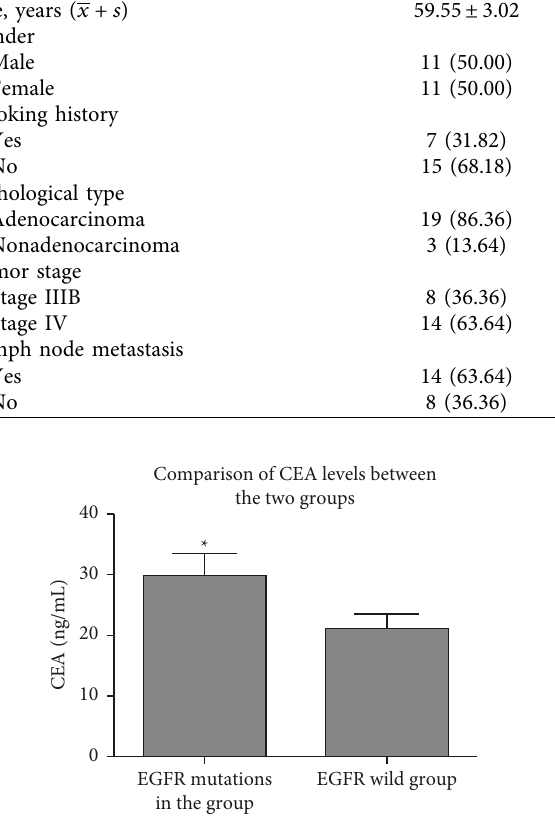
Figure 3: Comparison of Cy21-1 levels of two groups. Note . ∗ P < 0 . 05.